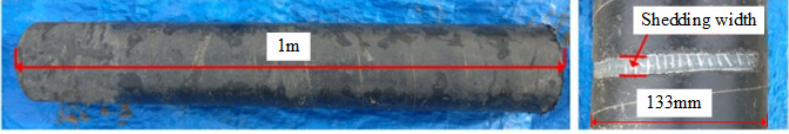
Figure 9. The picture of underwater metal pipeline.